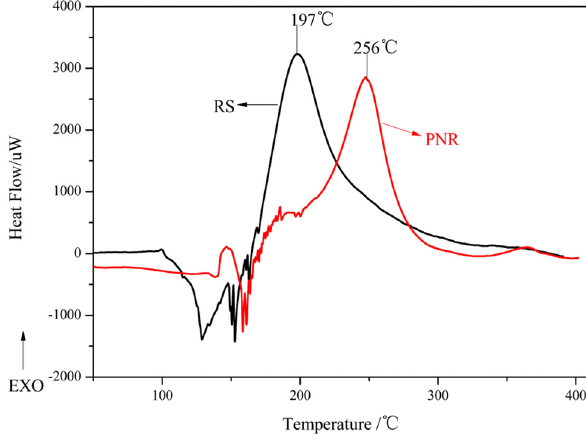
Figure 5: DSC results of PNR and RS.